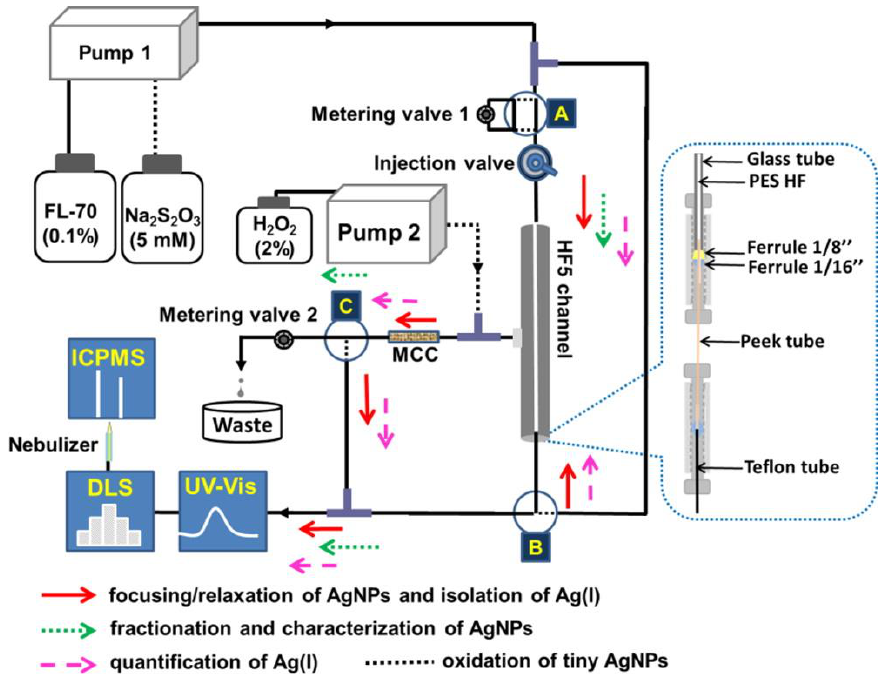
Figure 4. Schematic representation of the on-line coupled HF5/MCC-UV/DLS/ICPMS analytical system. Reprinted from [29] copyright (2015), with permission from ACS (further permission should be directed to the ACS).